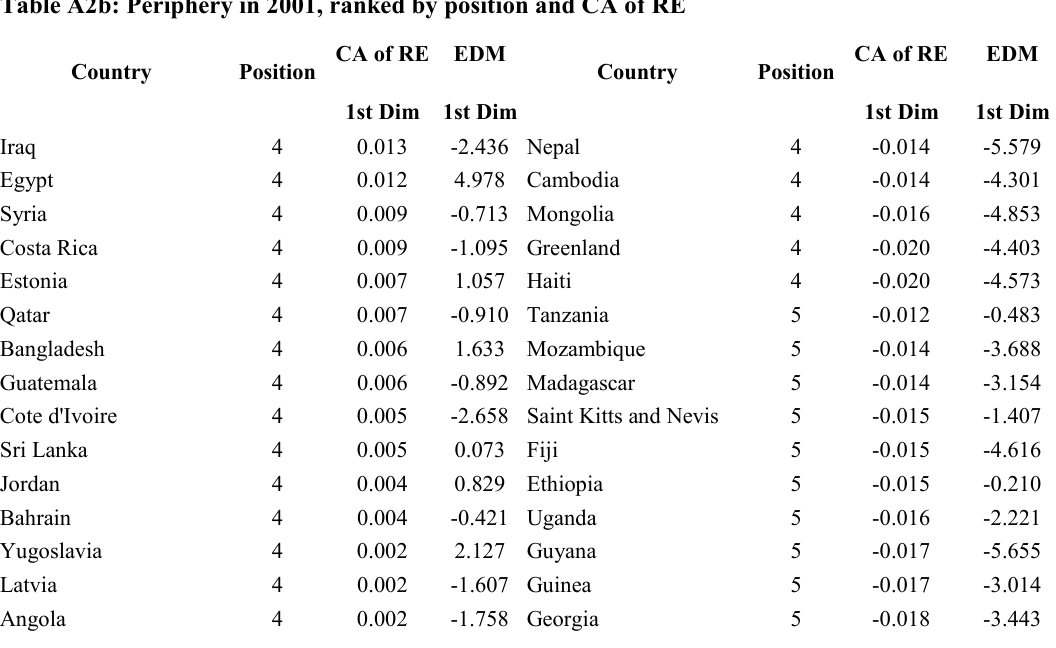
Table A2b: Periphery in 2001, ranked by position and CA of